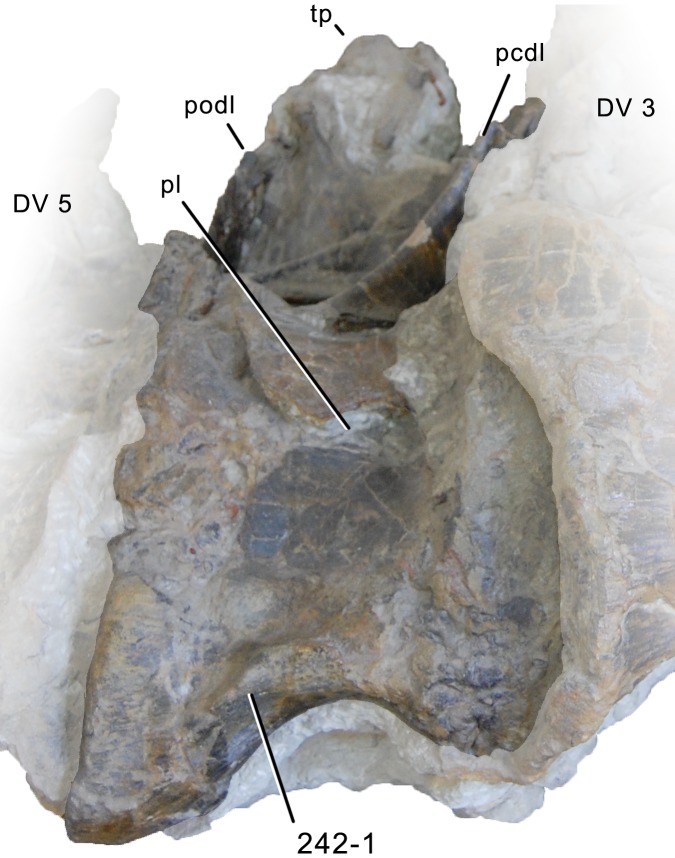
Dorsal vertebra 4 of “Dinheirosaurus” lourinhanensis ML 414 in ventral view.Note the ventral keel (C242-1) in anterior dorsal vertebrae. Abb.: DV, dorsal vertebra; pcdl, posterior centrodiapophyseal lamina; pl, pleurocoel; podl, postzygodiapophyseal lamina; tp, transverse process.